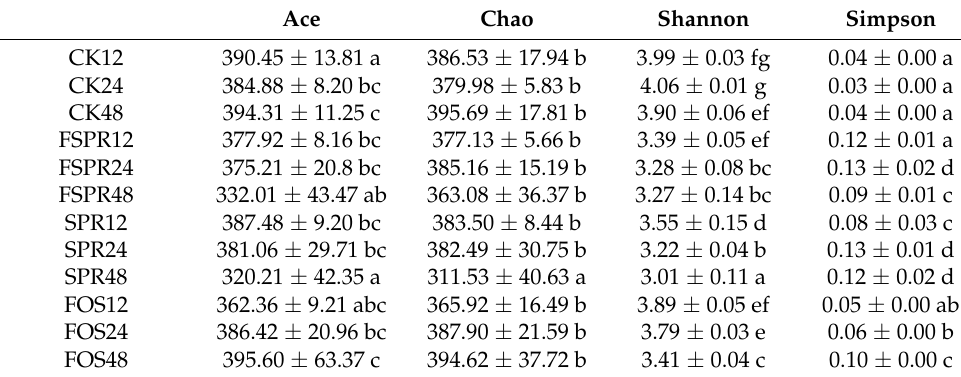
Table 3. Microbial α -diversity analysis of FSPR during in vitro colonic fermentation. Ace Chao Shannon Simpson